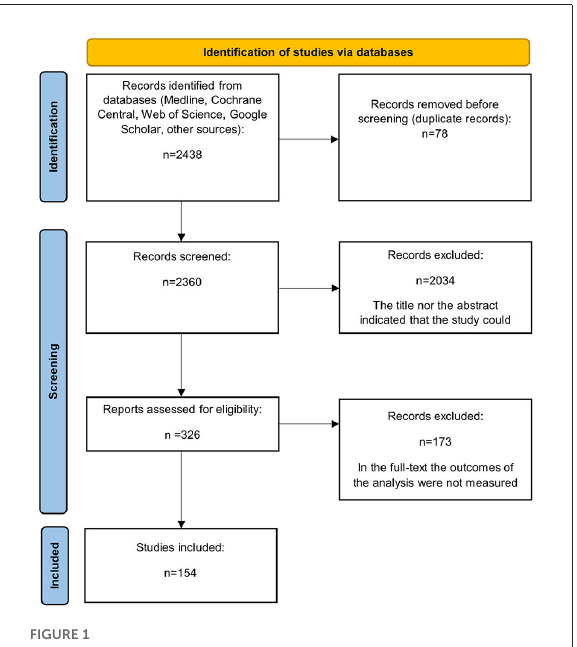
FIGURE1 PRISMA flow chart of systematic review search process.